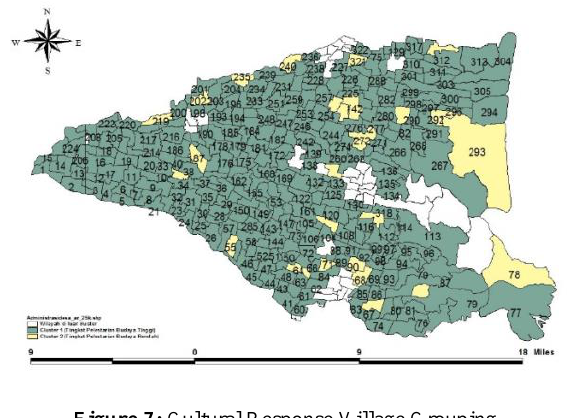
Figure 7: Cultural Response Village